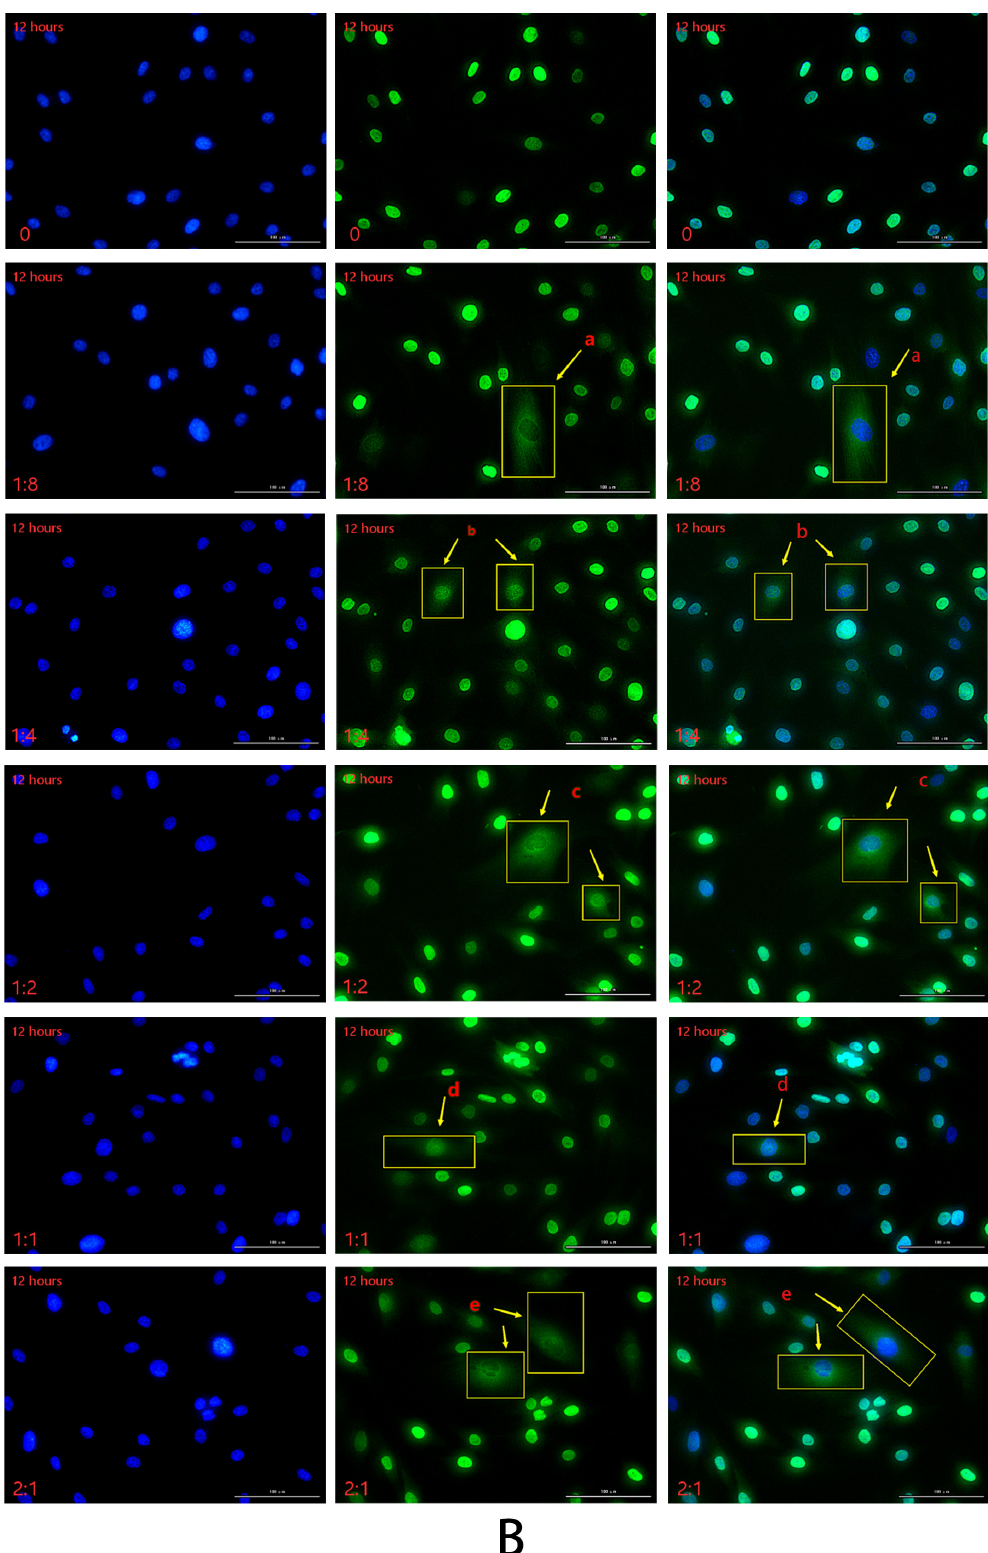
Figure 7. The immunofluorescence staining map of VEGFA and FGF2 proteins secreted by HSFs in the cell co-culture system. ( A ) The immunofluorescence staining of VEGFA protein secreted by HSFs after cell co-culture for 12 h. ( B ) The immunofluorescence staining of FGF2 protein secreted by HSFs after cell co-culture for 12 h. Scale bar: 100 µ